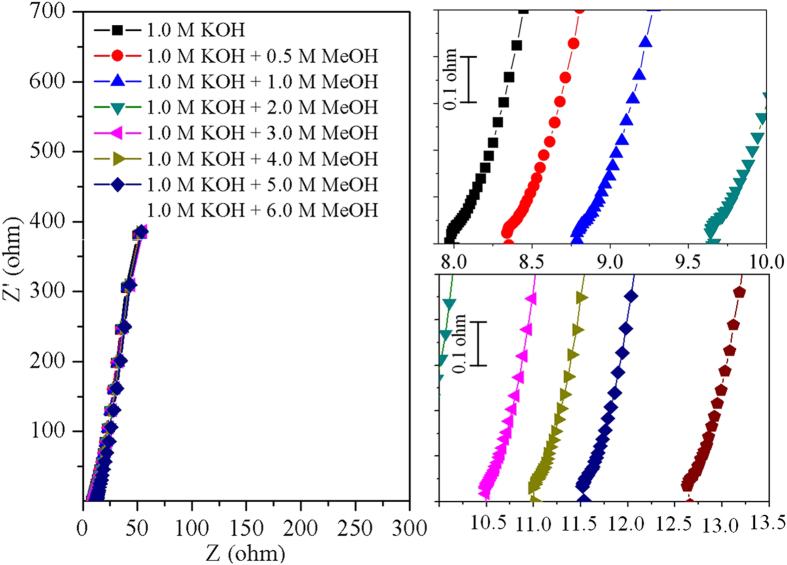
Impedance response of NiCo2O4/MWCNT in 1.0 M KOH, and 1.0 M KOH with 0.5 M, 1.0 M, 2.0 M, 3.0 M, 4.0 M, 5.0 M, and 6.0 M MeOH.